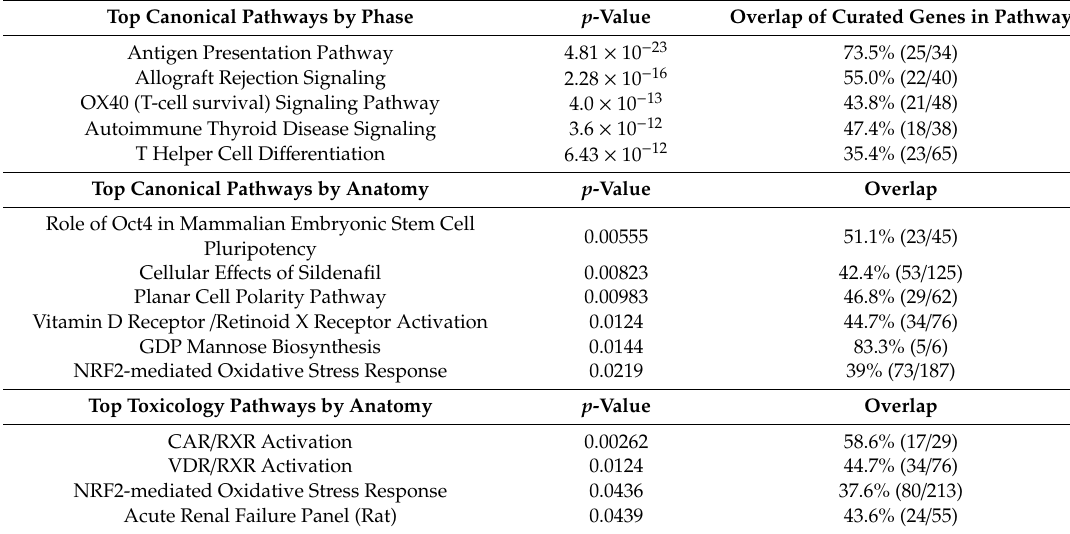
Table 1. Summary of top di ff erentially regulated pathways between fimbria versus ampulla using Ingenuity Pathway Analysis. Gene list for each pathway can be found in Dataset